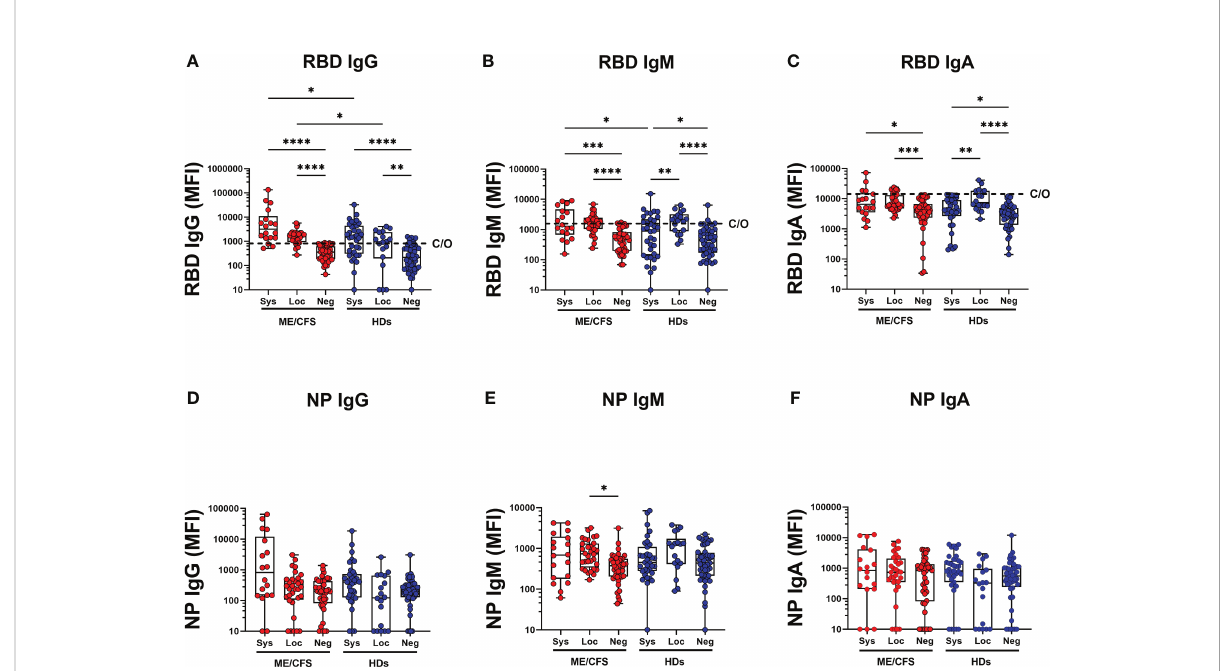
FIGURE 2 SARS-CoV-2 RBD and NP antibodies in systemic and local responders in ME and HDs. (A) SARS-CoV-2-RBD (RBD) for IgG, (B) IgM and (C) IgA class. SARS-CoV-2 NP (NP) for (D) IgG, (E) IgM and (F) IgA class. Systemic: Participants RBD-positive for systemic response in plasma. Local: Participants RBD-positive for local response in saliva. Negative: Participants patients RBD-negative both in plasma and saliva. Data are presented as boxplots with median values and 25 th and 75 th percentile. MFI, median fl uorescence index. Statistically signi fi cant differences according to nonparametric Kruskal/Wallis procedure and false discovery rate adjustment (5%), are indicated as * p < 0.05 , ** p < 0.01 , *** p < 0.001 and **** p < 0.0001 . Dashed horizontal lines marked C/O in (A-C) indicate saliva cut-off levels as explained in Figures 1